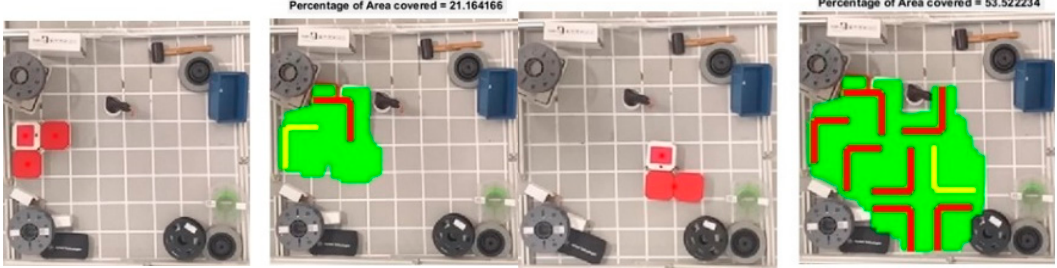
Figure 21. Tiling Process with Lemma 5 tile set.